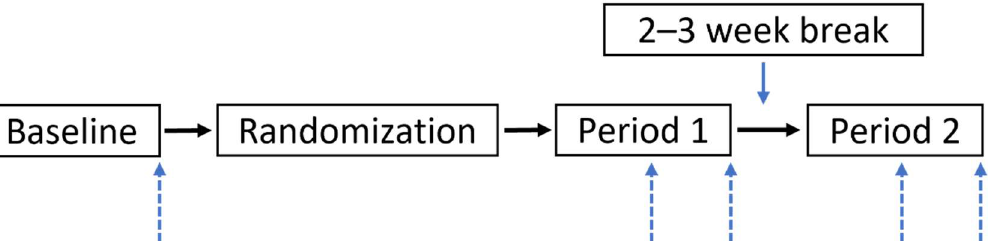
Figure 1. Study design. A randomized cross-over study was conducted where participants consumed a refined grain side dish and a non-fried potato side dish in random order daily for 4 weeks each, with a 2–3-week washout period in between conditions. Up arrows signify fecal sample collection days at baseline and at the midpoint and end of each condition (weeks 2 and 4).